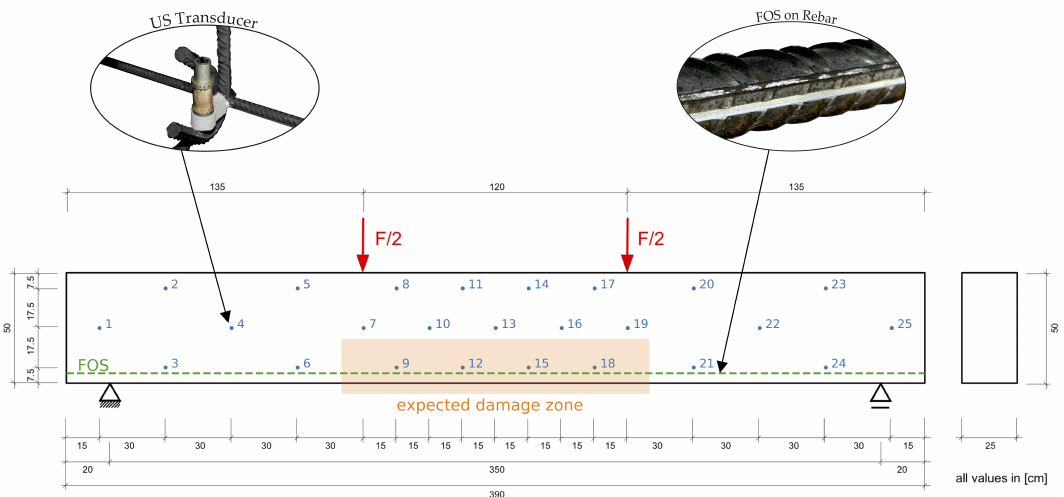
Figure 3. Dimensions of the test specimen with FOS in green and US transducers in blue. Results of the US transducer 16 proved to be erroneous and were not taken into account for the